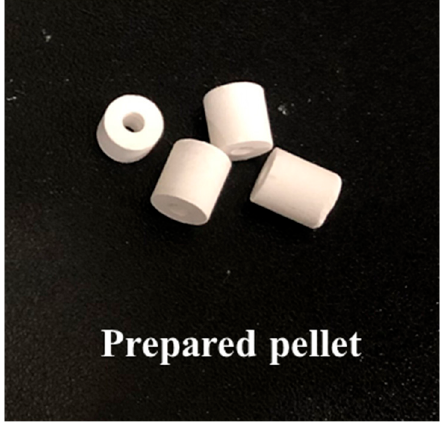
Figure 12. Image of the prepared pellet support.